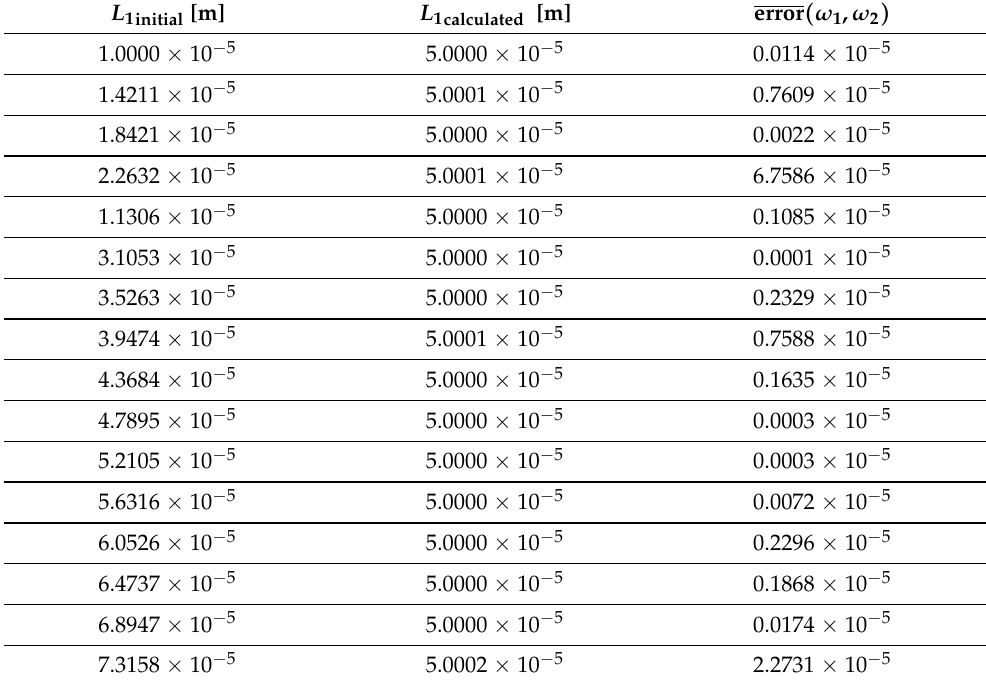
Table 5. Results for case